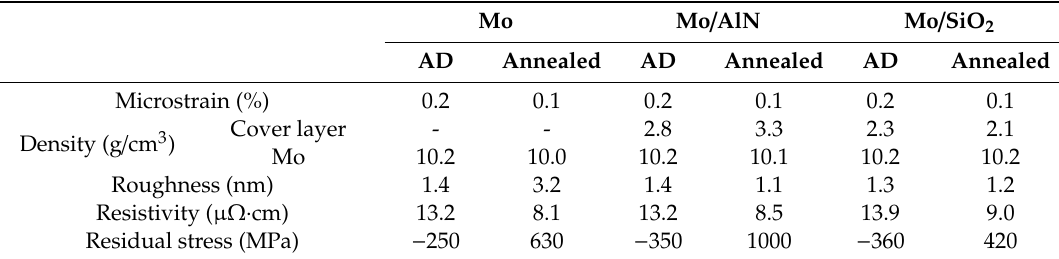
Figure 1. X-ray diffraction patterns of the Mo films with and without AlN or SiO 2 cover layer in the as deposited state and after thermal treatment. ( a ) Full measurement regime; ( b ) zoom of the Mo (110) and AlN (002) peak (inset). Table 1. Microstrain, density of the cover layer and Mo film, roughness, resistivity, and residual stress at room temperature for the as-deposited (AD) and thermally cycled (annealed) Mo films with and without AlN or SiO 2 cover layer. (±0.1 g/cm 3 , ±0.06 nm, ±0.3 μΩ ·cm and ±10 MPa of errors in density, roughness, resistivity, and stress measurements, respectively.)